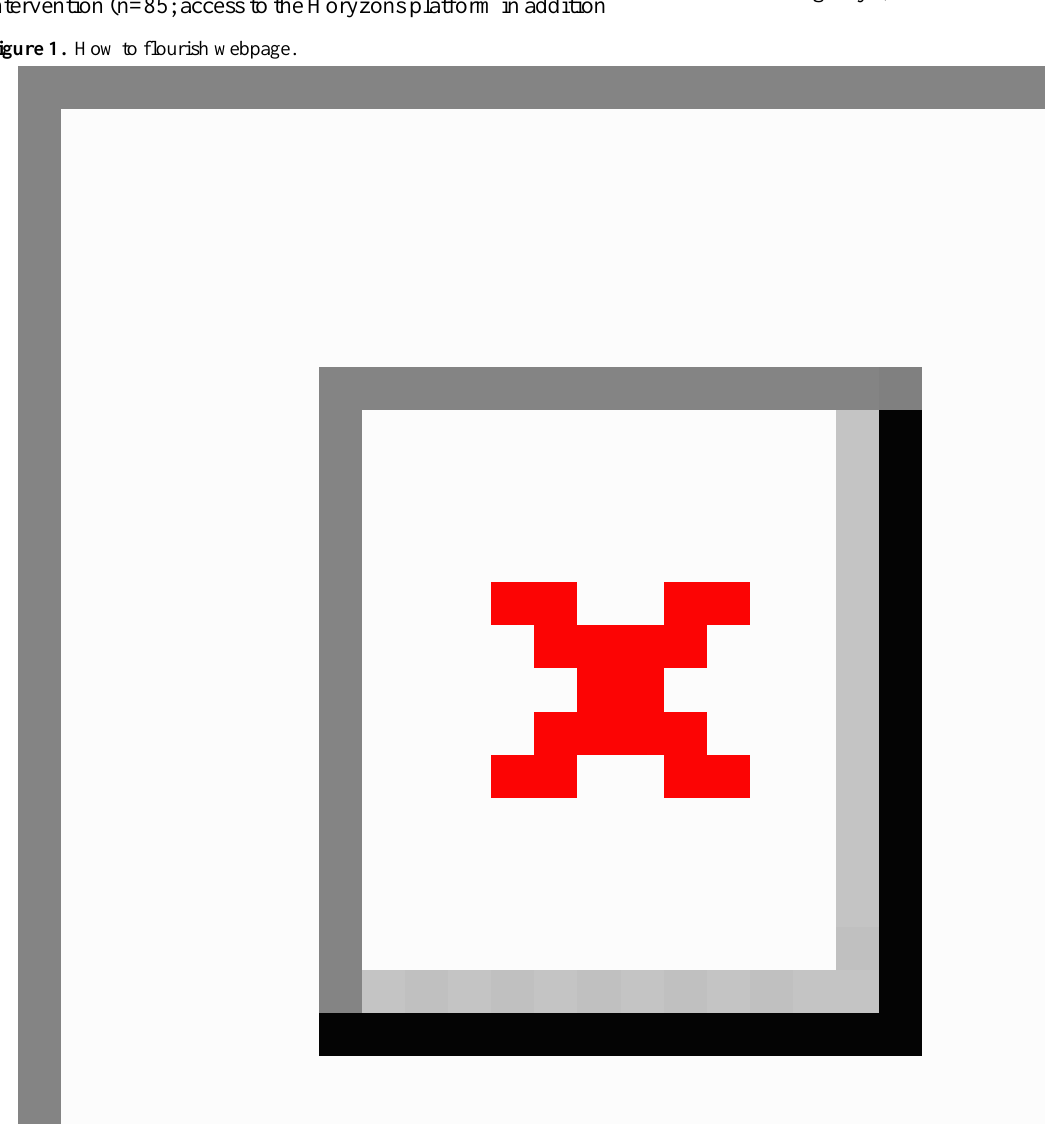
Figure 1. How to flourish